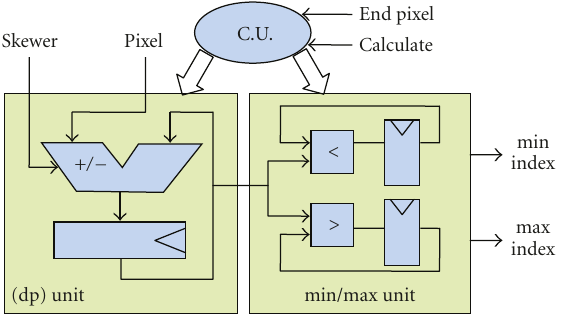
Figure 7: Hardware architecture of a dot-product processor.